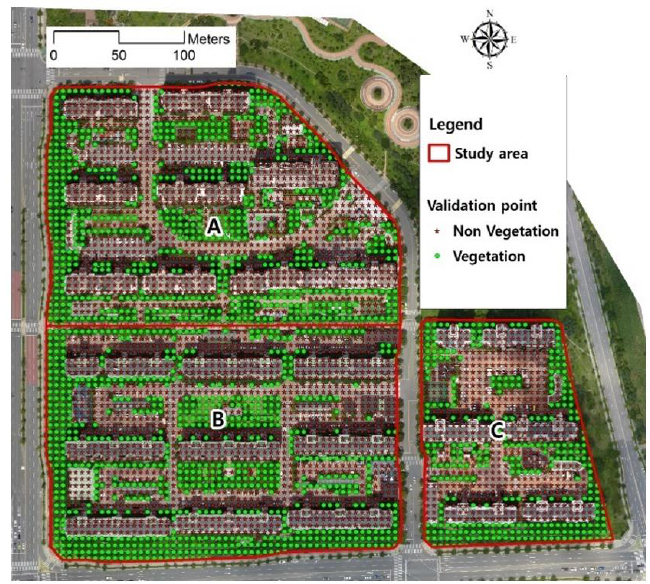
Figure 17. Validation points selected at 5 m intervals.